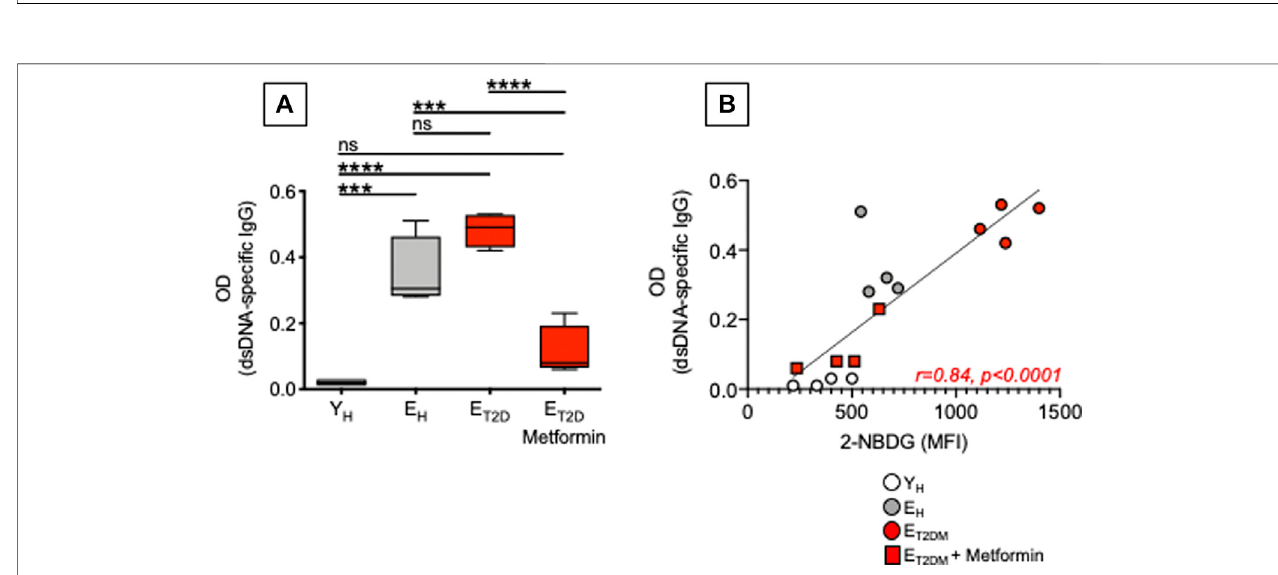
FIGURE 6 | Metformin decreases autoimmune antibody secretion in CpG-stimulated B cells from E T2DM patients. (A) Results show OD values at 1:200 sample dilution. (B) Correlations of anti-dsDNA IgG (OD values) with 2-NBDG MFI. Pearson ’ s regression coef fi cients and p values are indicated at the bottom of the fi gure.